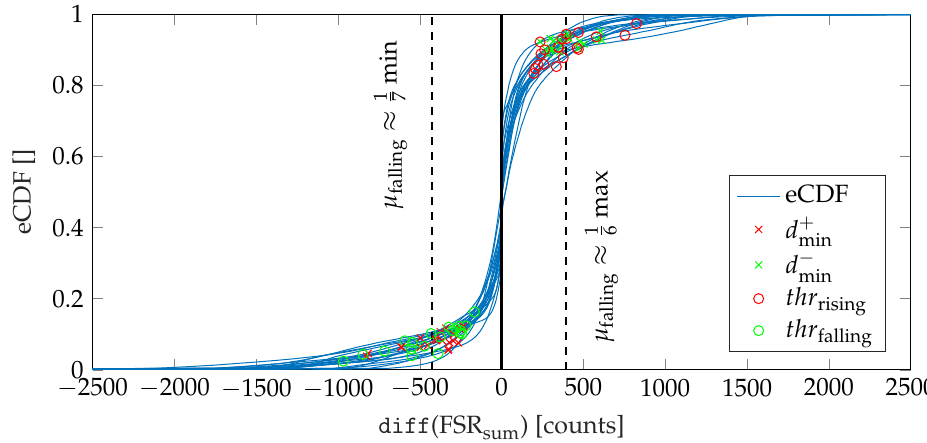
Figure 8. Illustration of the procedure for determining the threshold values used for the detection of HS and TO